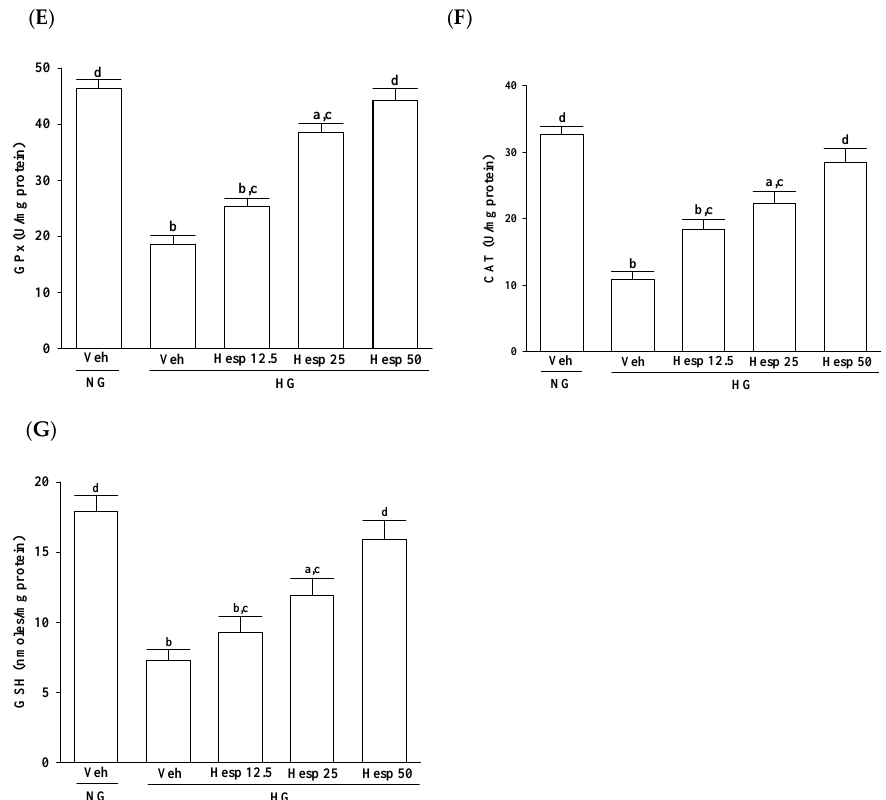
Figure 2. Effects of hesperidin on reactive oxygen species (ROS)production, lipid peroxidation, protein carbonylation, and endogenous antioxidant defense in RGC-5 cells following high-glucose challenge: ( A ) ROS levels; ( B ) lipid peroxidation levels; ( C ) total protein carbonyl content; and ( D ) levels of: superoxide dismutase (SOD); ( E ) glutathione peroxidase (GPx); ( F ) catalase (CAT); and ( G ) glutathione (GSH). The RGC-5 cells were cultured with normal (NG) or high glucose (HG) plus hesperidin at concentrations of 12.5 (Hesp 12.5), 25 (Hesp 25), or 50 μ mol/L for 48 h. The experiments were performed in triplicate and data are presented as mean ± SD of five independent experiments ( n = 5). a p < 0.05 and b p < 0.01 when compared with the normal-glucose vehicle (Veh)-treated group. c p < 0.05 and d p < 0.01 when compared with the high-glucose vehicle-treated